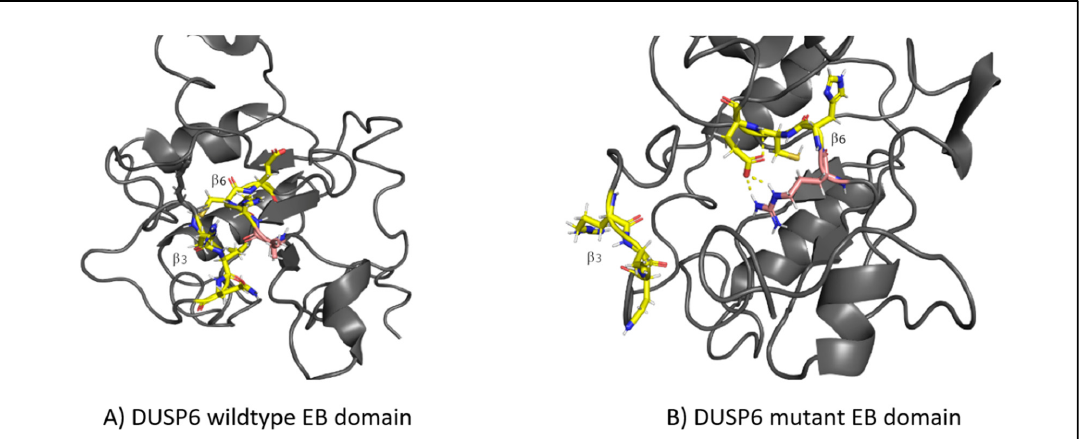
Figure 5. ( A ) The structure of the β -sheet (highlighted in yellow) in the wild-type DUSP6, with β 3 tethering to β 6. ( B ) The disruption of the β -sheet structure in the mutant DUSP6, with β 3 untethering from β 6. The mutation is highlighted in pink.